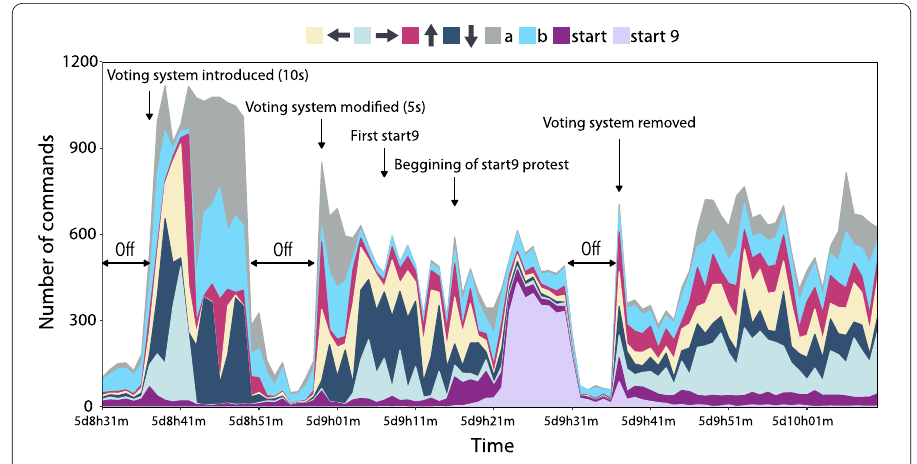
Figure 2 Command distribution after the first introduction of the voting system. Once the system was back online votes would tally up over a period of 10 seconds. After 15 minutes the system was brought down to reduce this time to 5 seconds. This, however, did not please the crowd and it started to protest. The first start9 was sent at 5d9h8m but went almost unnoticed. Few minutes after it was sent again but this time it got the attention of the crowd. In barely 3 minutes it went from 4 start9 per minute to over 300, which stalled the game for over 8 minutes. The developer brought down the system again and removed the voting system, introducing the anarchy/democracy system a few hours